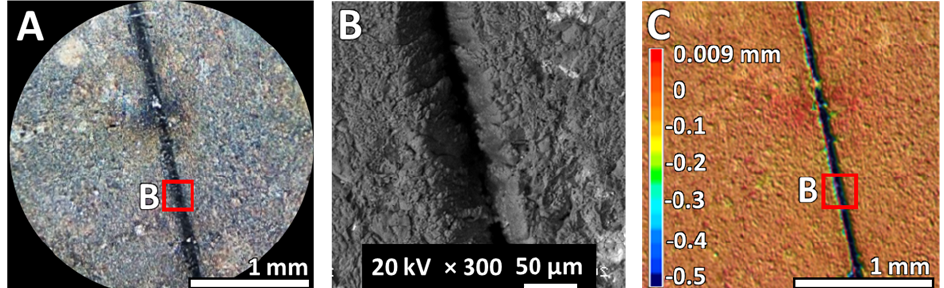
Figure 7. Ablation site for the Ti:Sapphire laser (linear shift) on the chodnritic meteorite SaU 567, examined by optical microscopy ( panel A ), scanning electron microscopy ( panel B ), and optical profilometry ( panel C ).